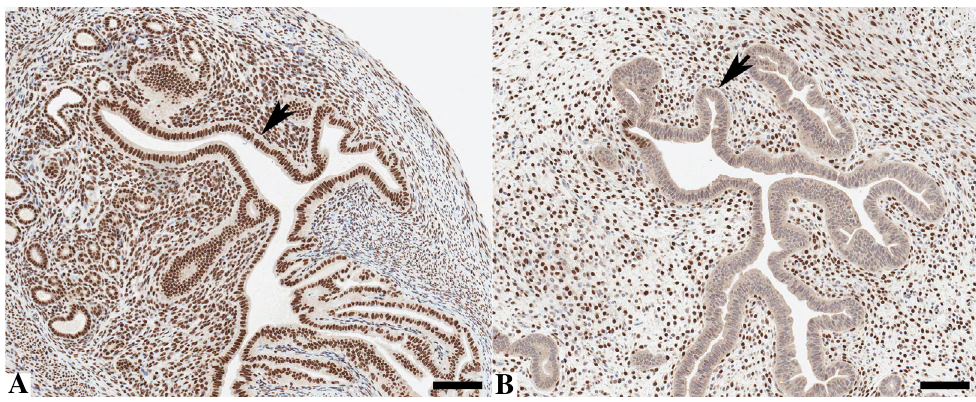
Figure 4. Murine uterine tissue stained by immunohistochemistry with anti-ARID1A demonstrating nuclear staining in wild-type mice ( A ) but loss of epithelial staining after ARID1A knock-out in Arid1a fl/fl mice ( B ). Bar = 100